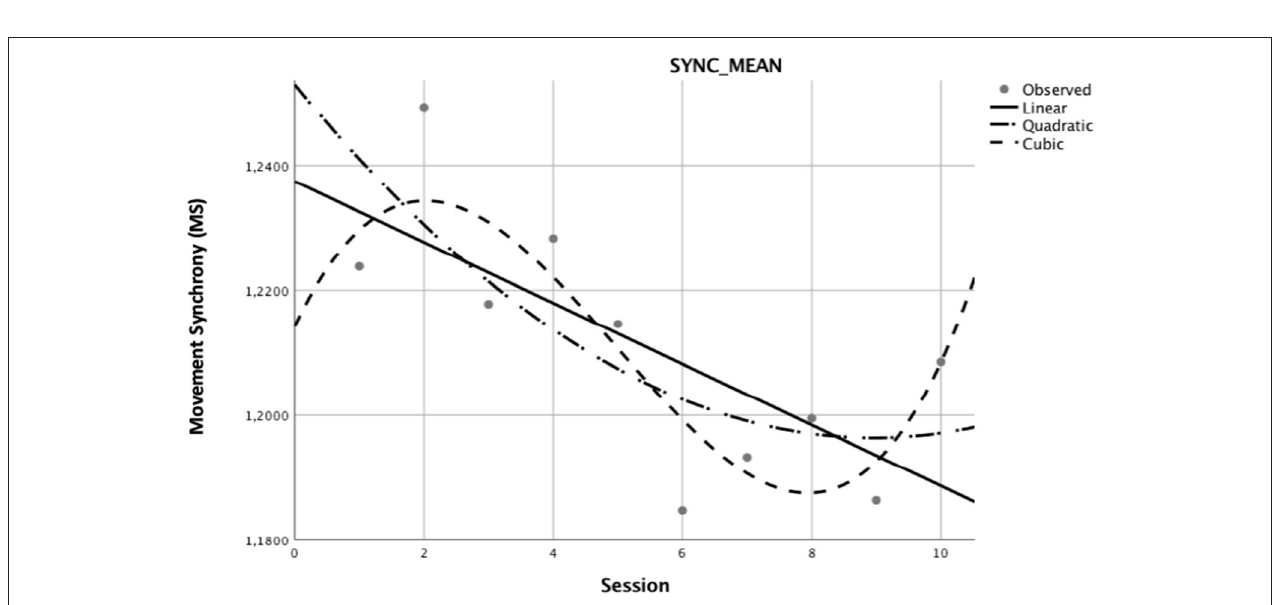
FIGURE 2 | Best curve fit related to mean movement synchrony. Reduced best fitting curves for Mean Synchrony of dyads ( N = 59) that completed coaching sessions represented in linear, quadratic, and cubic curves. The y-axis depicts the index of MS calculated as an expression of the movement coordination between coach and client.